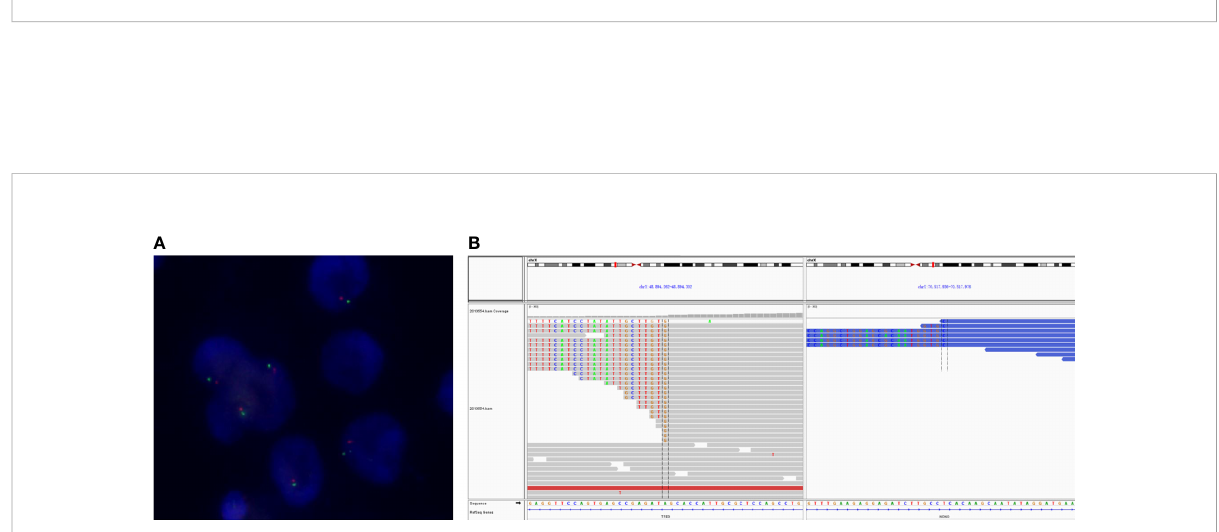
FIGURE 3 The typical FISH and RNA-sequencing results of NONO-TFE3 renal cell carcinoma. (A) FISH shows a single pair of separated red and green signals but remains in close proximity. (B) A fusion of TFE3 (doner end: chrX: 48894302) and NONO (acceptor start: chrX: 70517936) was detected in the tumor visualized in the Integrative Genomics Viewer.